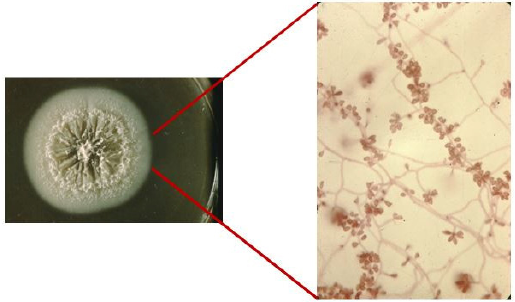
Figure 1. Sporothrix spp. culture and erythromycin staining 40X.